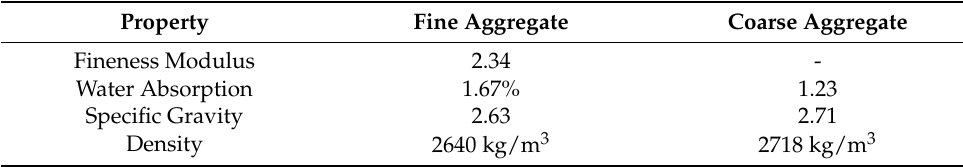
Table 3. Properties of fine and coarse